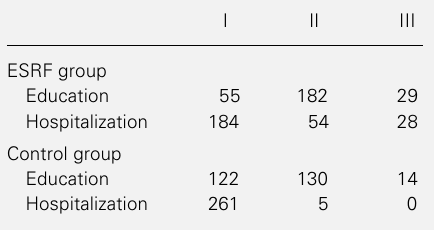
Table 2 - Distribution of subjects from the two groups studied according to educational level and number of hospitalizations due to